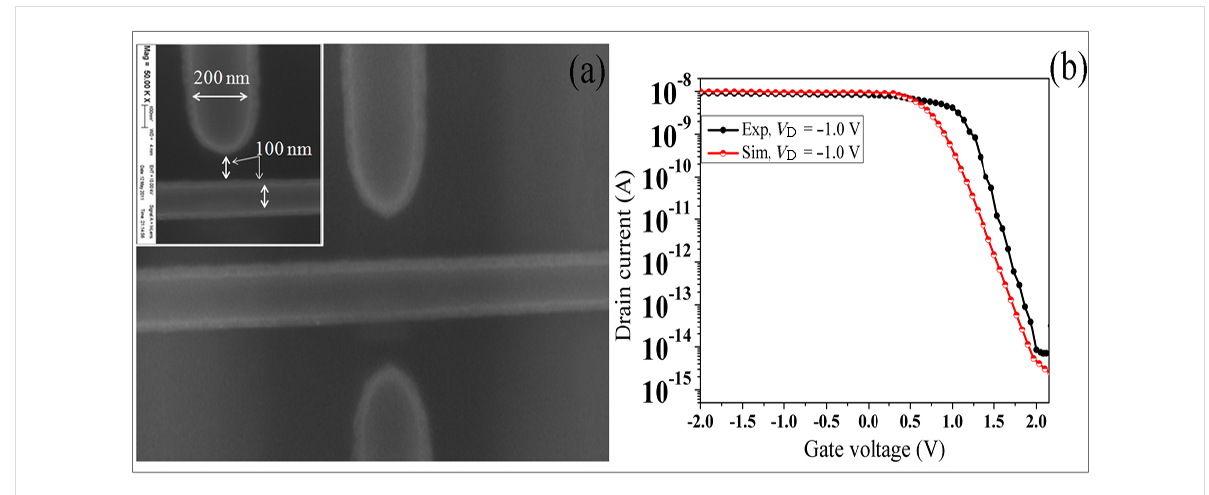
Figure 4: (a) SEM image of the gated area. (b) Experimental measurement and simulated transfer characteristics of DGJLT at V DS = − 1.0